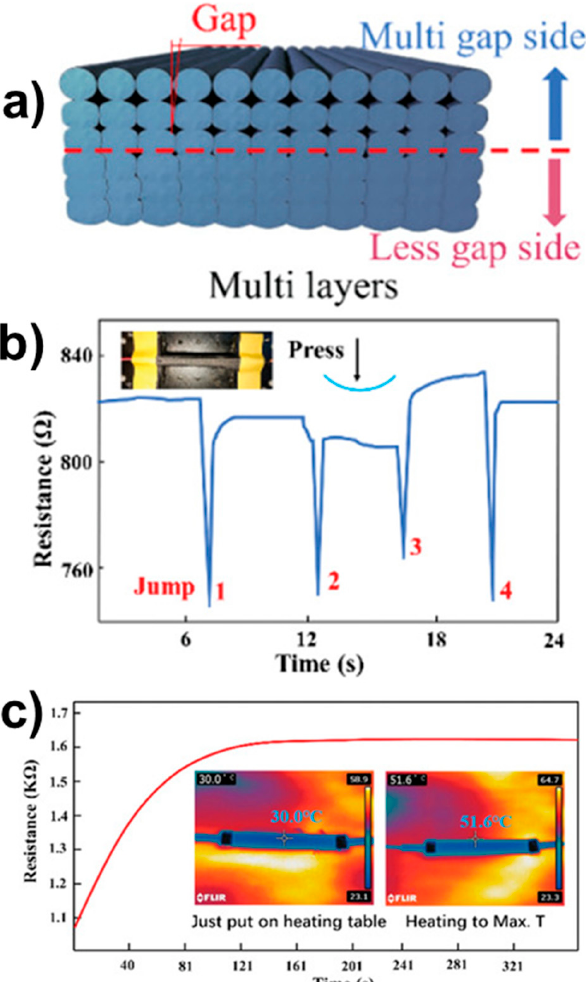
Figure 12. Self-sensing technology to detect strain and temperature variation in 3D printed PLA/carbon black composite: ( a ) material design showing gaps, ( b ) resistance variation when the composite is subjected to compression, and ( c ) resistance variation when the composite is sub- jected to a temperature increase from 30 °C to 52.6 °C [91] (copyright (2020), with permission from Wiley-VCH Verlag GmbH & Co).